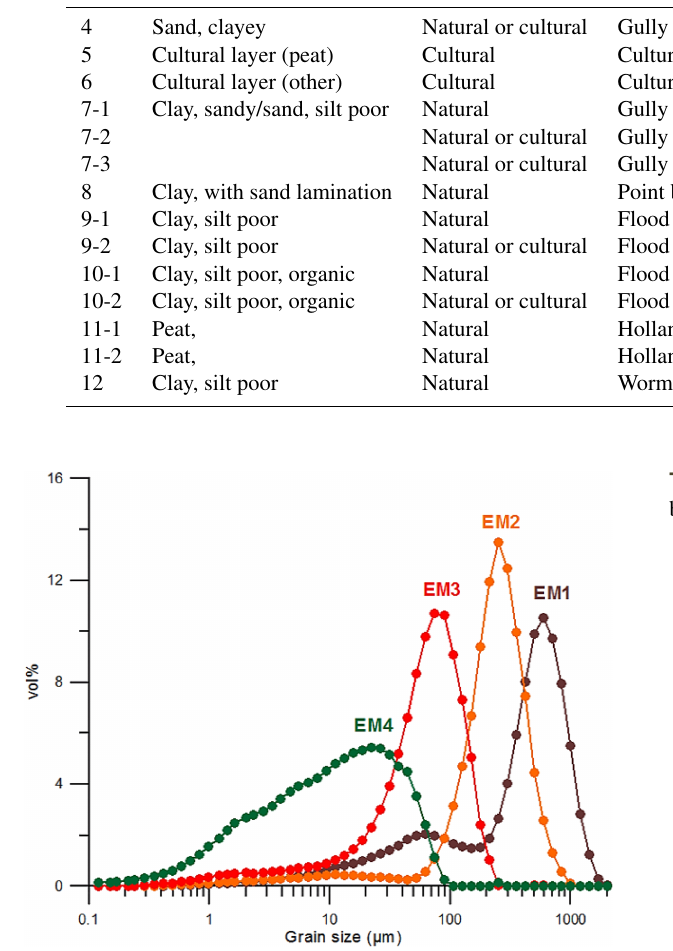
Figure 4. Modelled grain size and division of endmembers in Vlaardingen Stadshart.